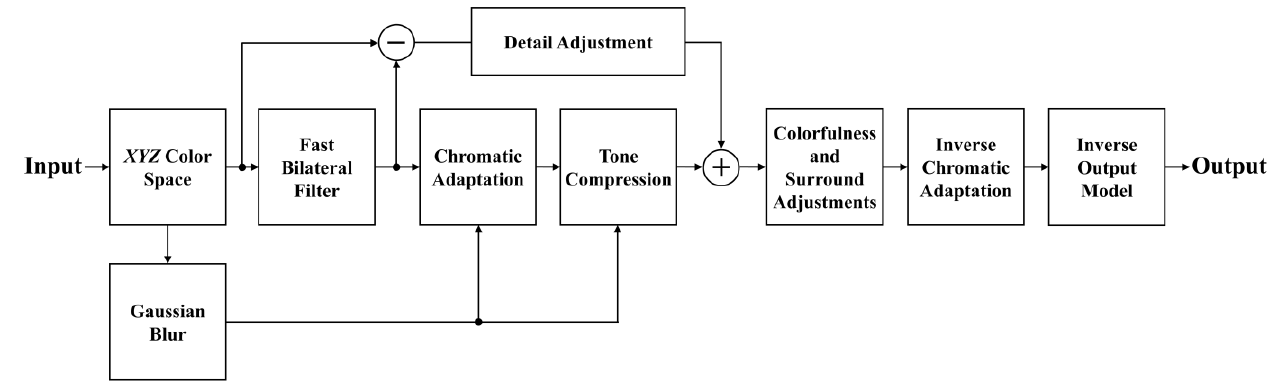
Figure 1. Flowchart of iCAM06.